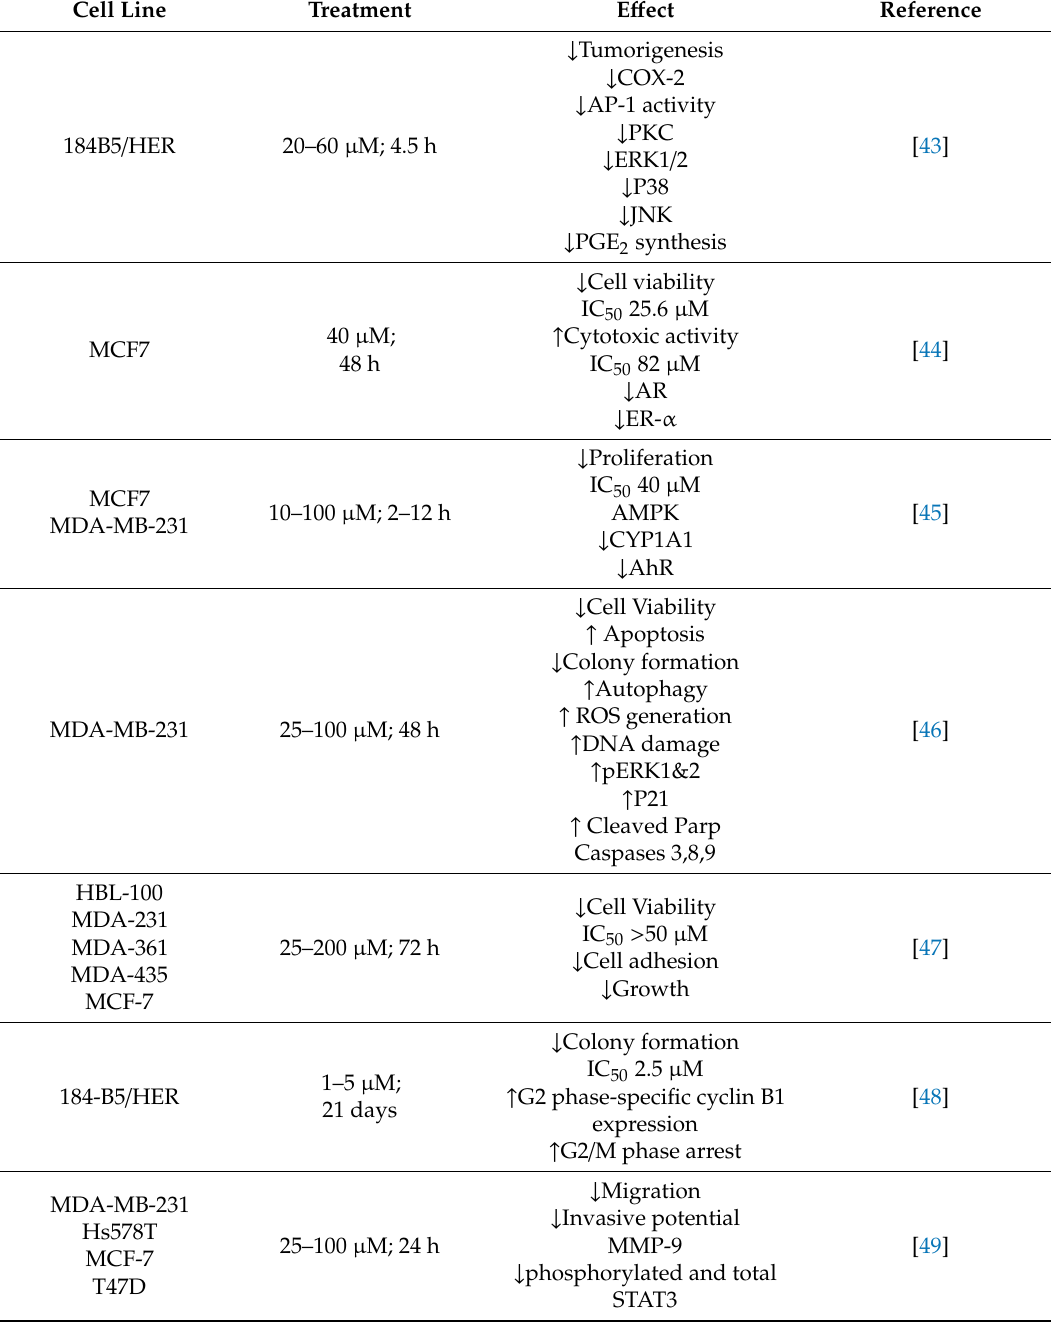
Table 3. E ff ects of carnosol on breast cancer in